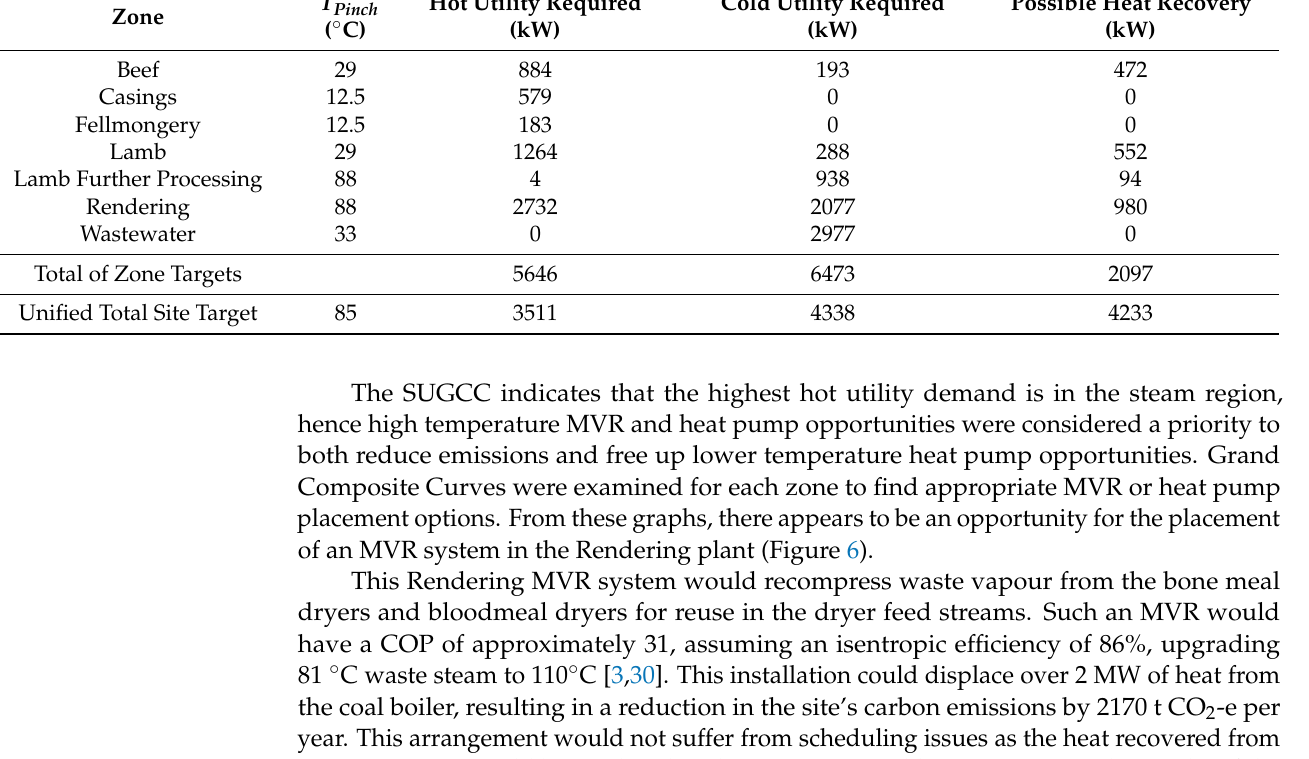
Table 1. Summary of results from TSHI of case study site zones.